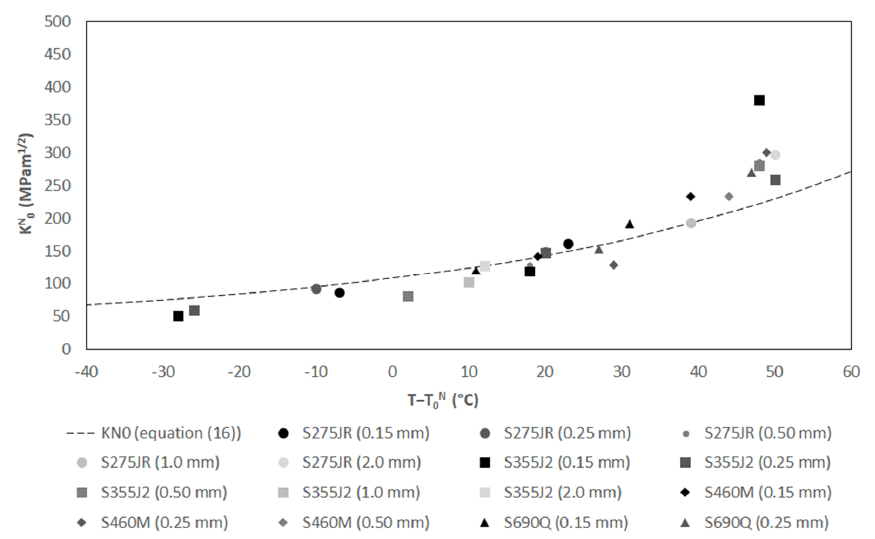
Figure 6. Apparent fracture toughness transition curve shape for cleavage fracture in ferritic steels containing notches, and comparison with the fracture toughness transition curve (Equation (17)) assumed by the Master Curve [4,5].